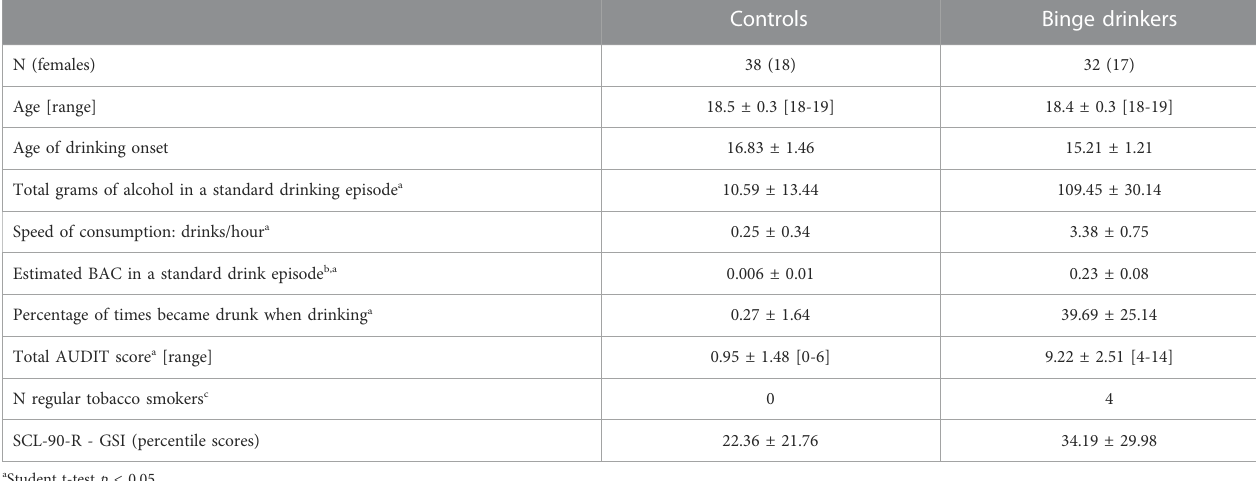
TABLE 2 Demographic and substance use characteristics of the sample (mean ± standard